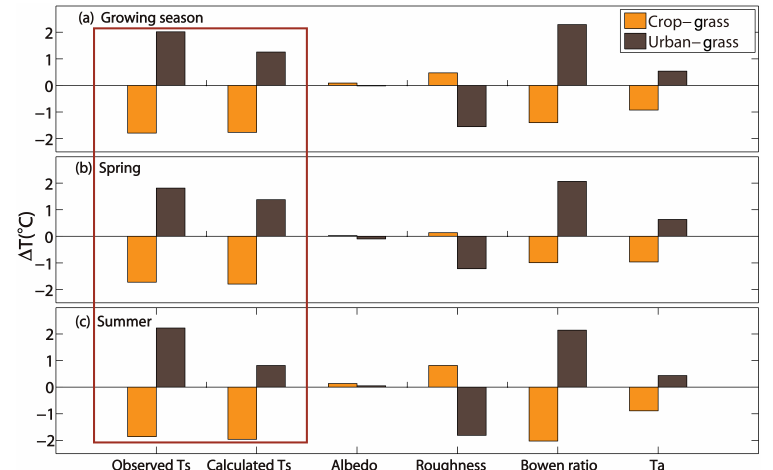
Figure 3. Contributions to the differences in surface temperature between urban and cropland sites and the grassland site due to radiation, aerodynamic resistance, evaporation, and air temperature ( T a ) in (a) the growing season, (b) spring, and (c) summer